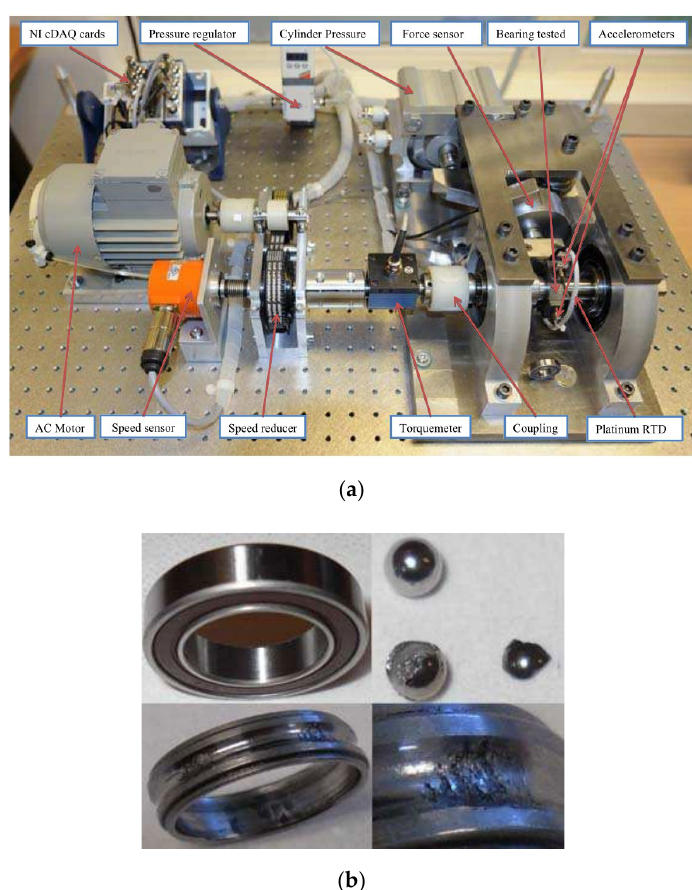
Figure 5. Test Rig. ( a ) Overview of PRONOSTIA; ( b ) normal and degraded bearing. Experimental dataset datasets are selected from different working conditions. The motor speed is 1800 rpm and the load is 4000 N in the first working condition; the motor speed is 1650 rpm and the load is 4200 N in the second working condition; the motor speed is 1500 rpm and the load is 5000 N in the third working condition. The specific in- formation is shown in Table 2. Table 2. The specific information of the sample data.